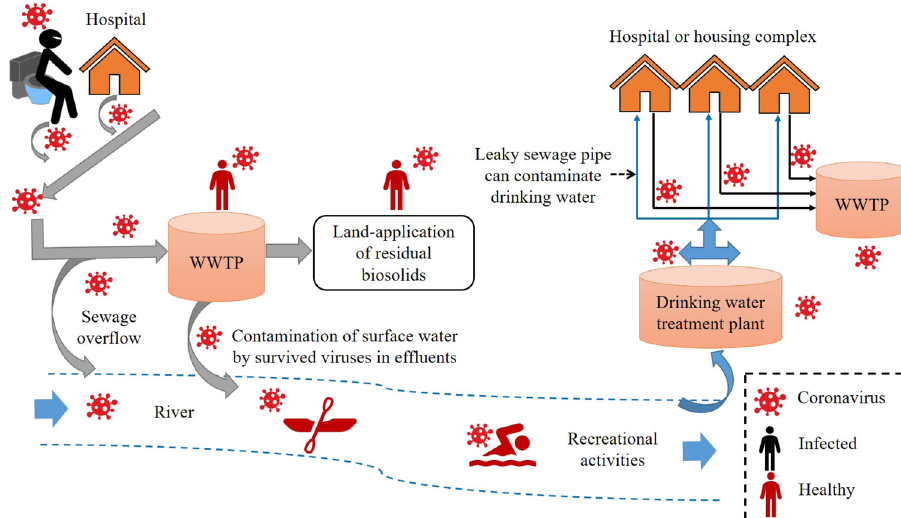
Fig. 3 The fate, occurrence, and transport of coronavirus in the urban water cycle. Reproduced with permission from Wigginton et al. 24 (Royal Society of Chemistry,